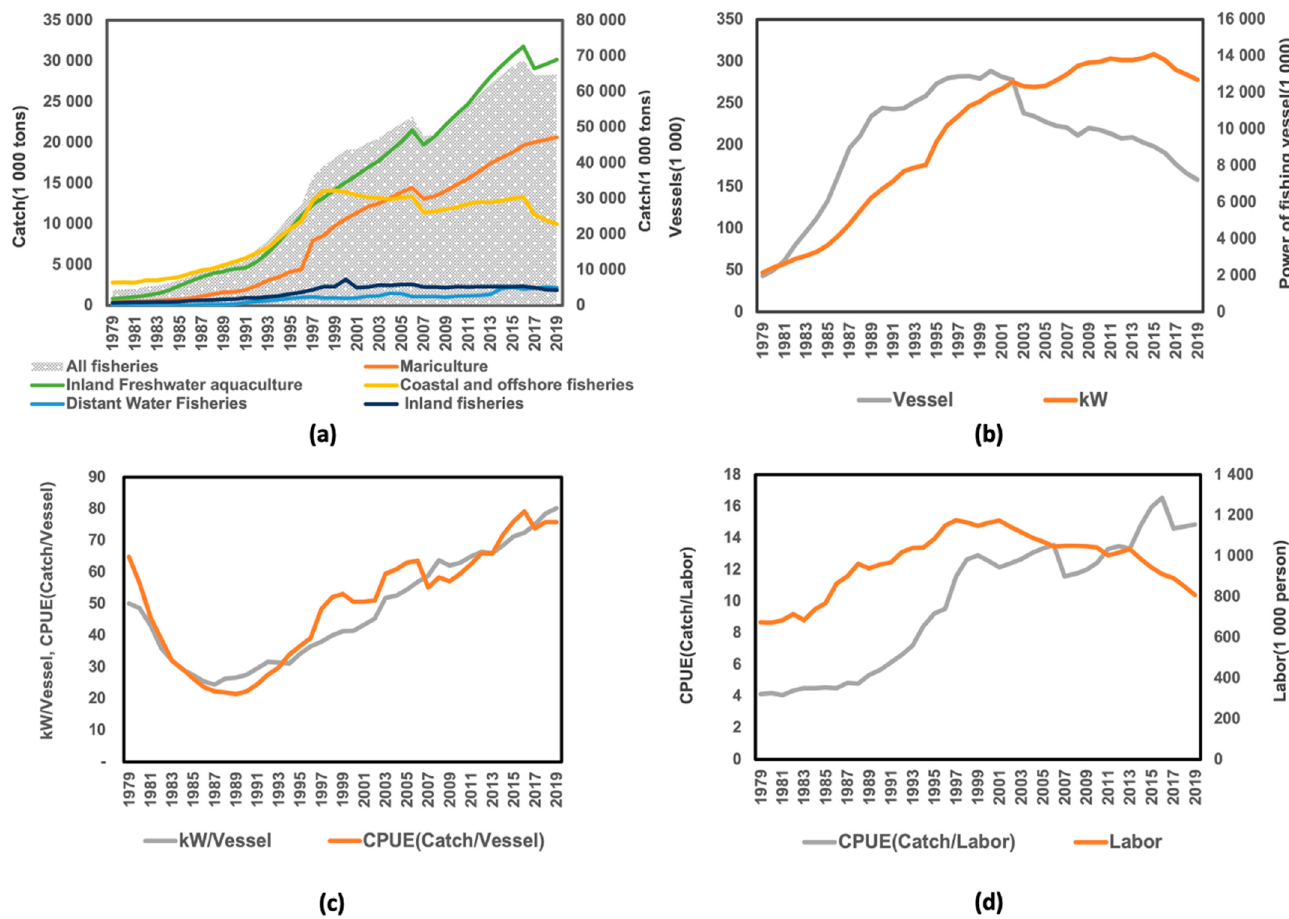
Figure 1. Trends of fisheries in China, from 1979 to 2019. ( a ) Production status per fishery; ( b ) Main fishing vessel engine power in coastal and offshore fisheries; ( c ) The average main fishing vessel engine power and catch-per-unit effort (CPUE) per vessel in coastal and offshore fisheries; ( d ) CPUE per labor and number of laborers in coastal and offshore fisheries [20,21].